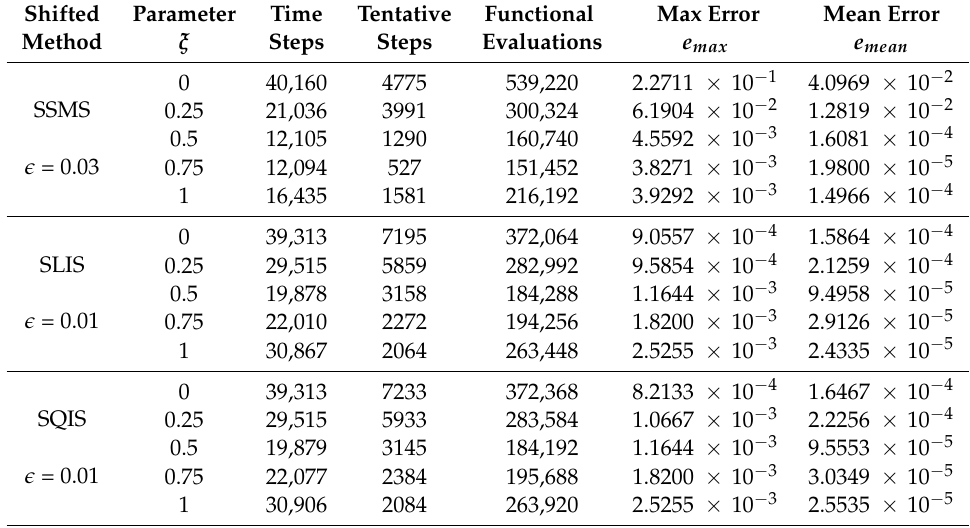
Table 14. Results of the shifted Strang–Marchuk’s splitting (SSMS), the shifted linear iterative splitting (SLIS), and the shifted quasilinear iterative splitting (SQIS), for the uphill case of the NLD equation with η = 1 × 10 − 5 and different values of the weight parameter ξ .